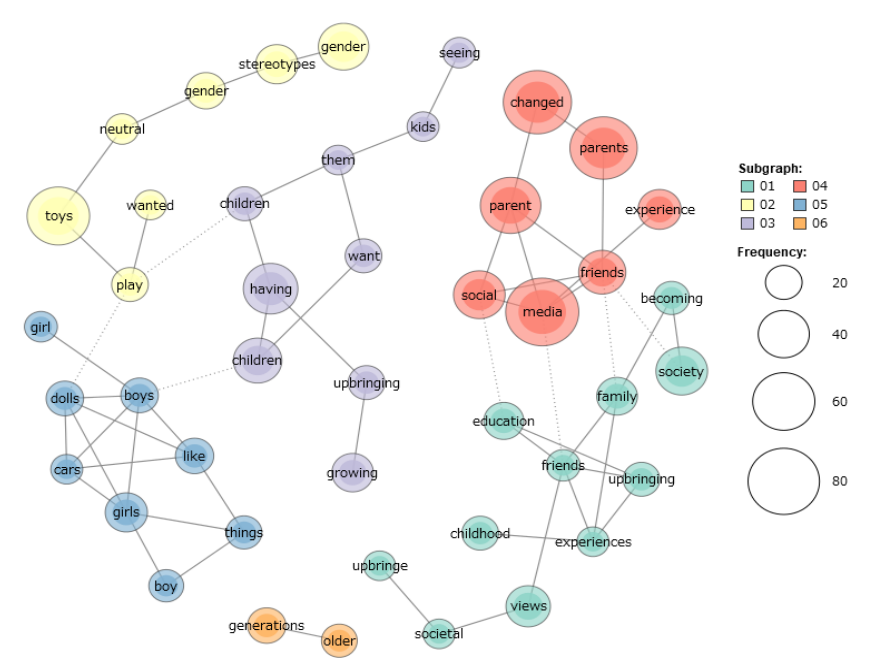
Figure 2. Co-occurrence